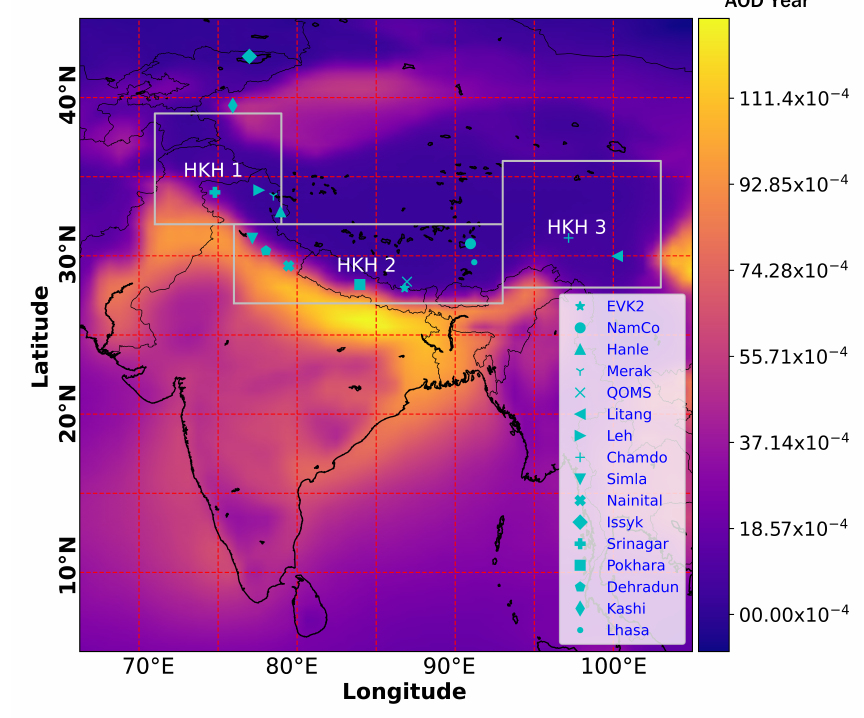
Figure 2. AOD trend across the Indian sub-continent in 1980–2020 using monthly MERRA-2